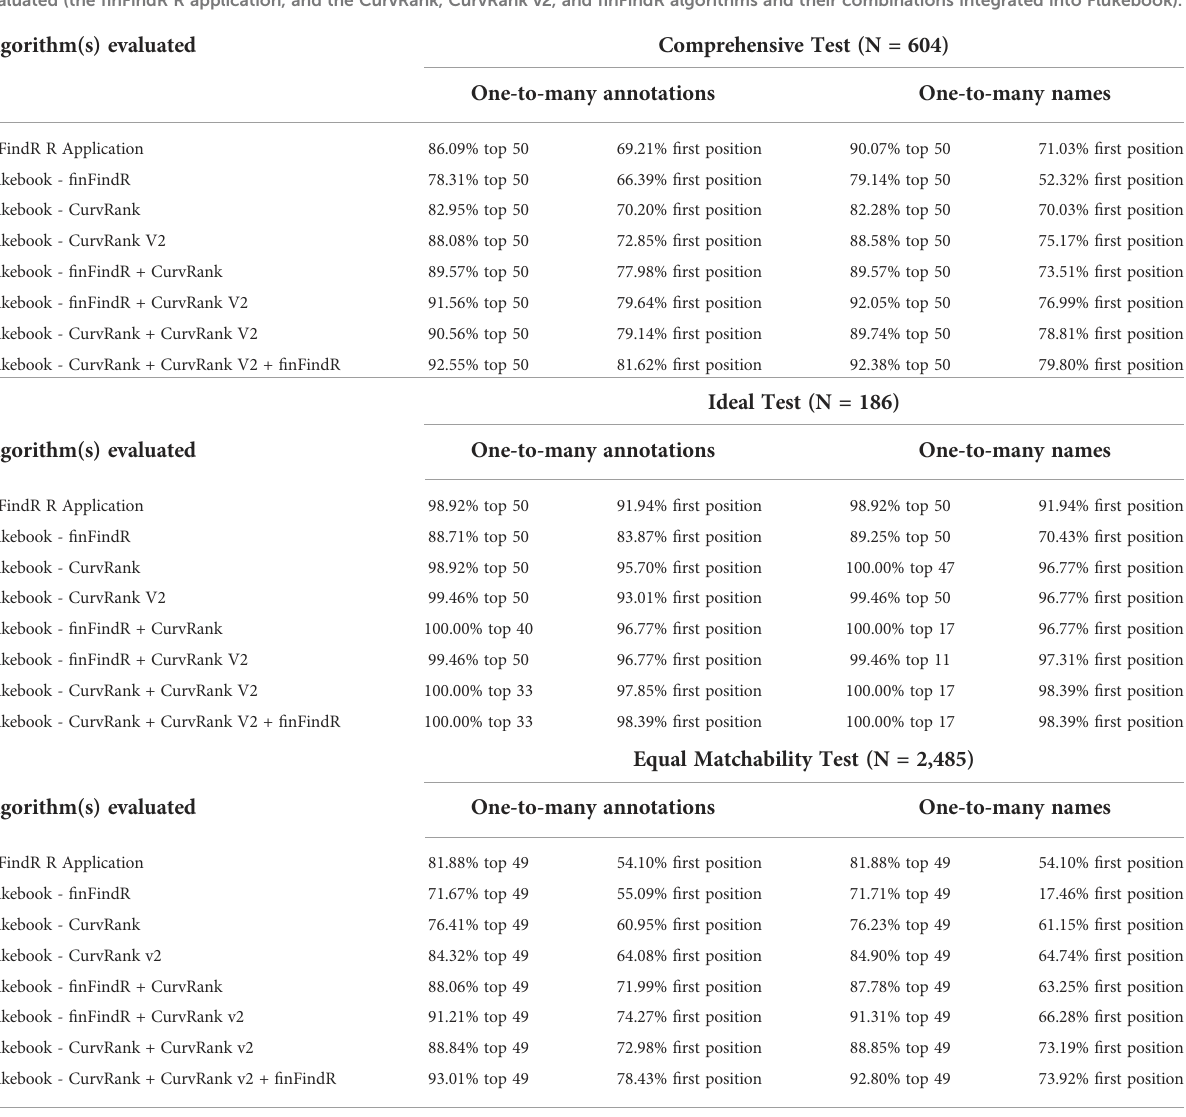
TABLE 1 The percentage of correct matches within the top-X ranked positions and the fi rst position for each dataset comparison test ( i.e. , comprehensive, ideal, and equal matchability tests for the one-to-many annotations and one-to-many names comparisons) and each algorithm evaluated (the fi nFindR R application, and the CurvRank, CurvRank v2, and fi nFindR algorithms and their combinations integrated into